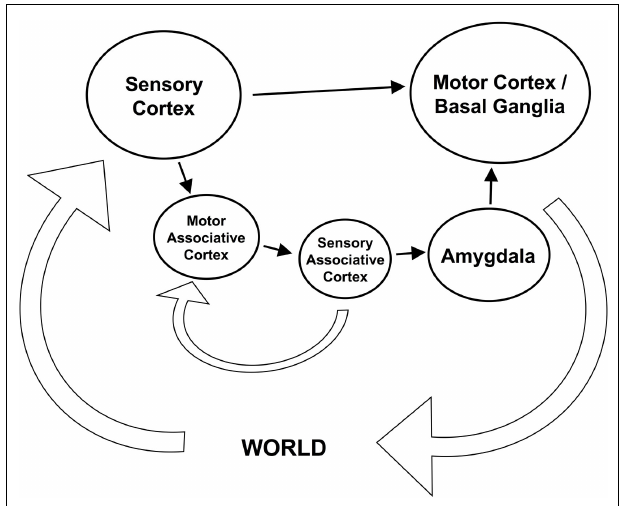
FIGURE 2 | The Global Workspace Theory cognitive architecture: achieving prospection by sensori-motor simulation [redrawn from Shanahan (2006)]